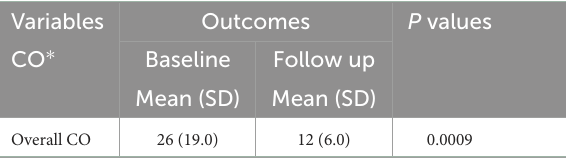
TABLE 3 Mean eCO levels at baseline and follow-up for all participants.